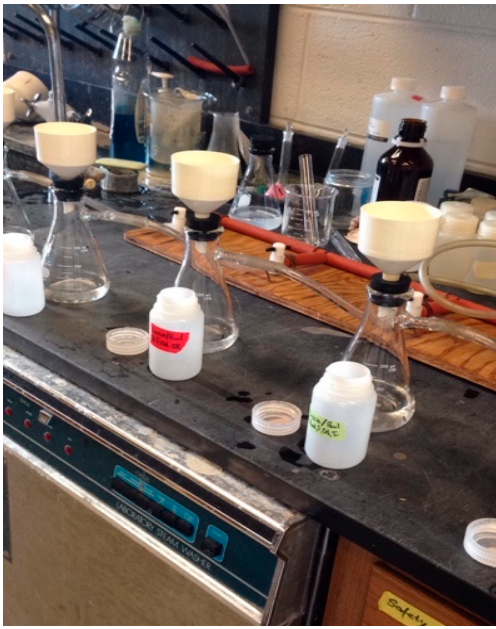
Figure 1. Autosamplers holding the samples, separated by water source. ( a ) autosamplers, with